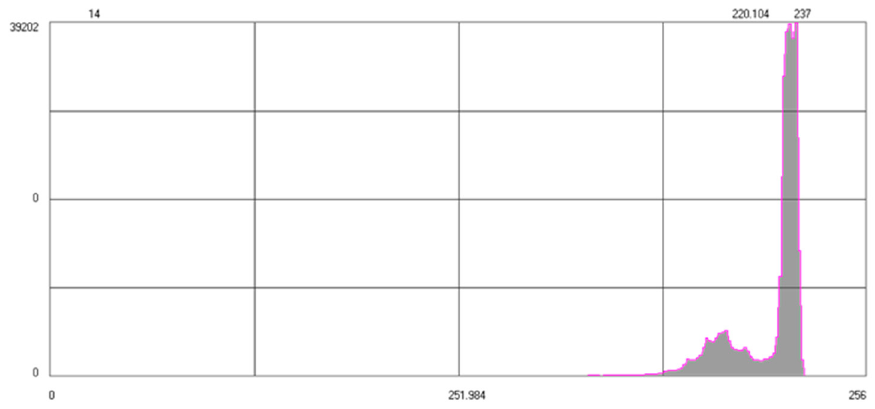
Figure 12. Contrast enhancement with the use of the thresholding method: ( a ) raw image; ( b ) image after thresholding.